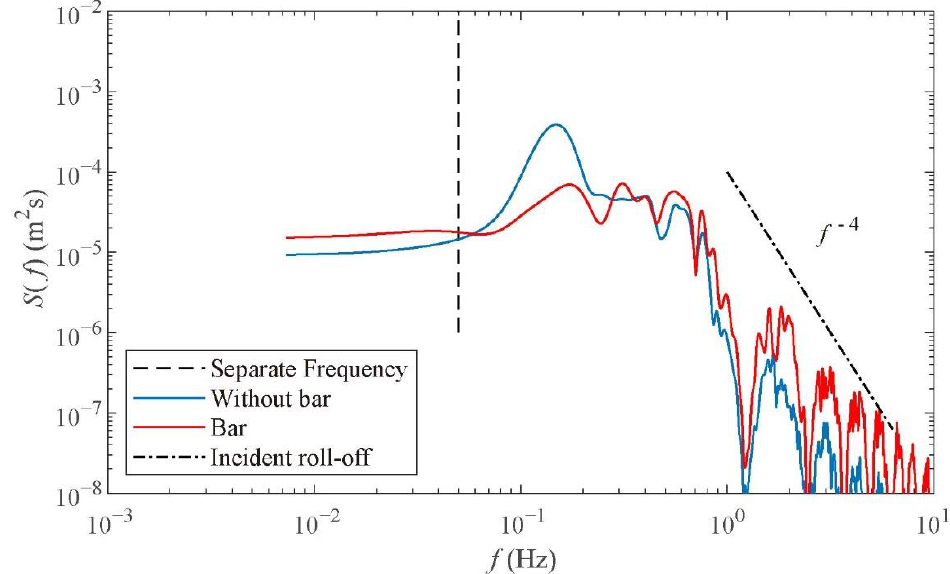
Figure 10. Swash spectrum with the same wave condition and different experiment profiles (T00, T0B). The black dash line is the separation frequency of the incident swash band and infragravity swash band.